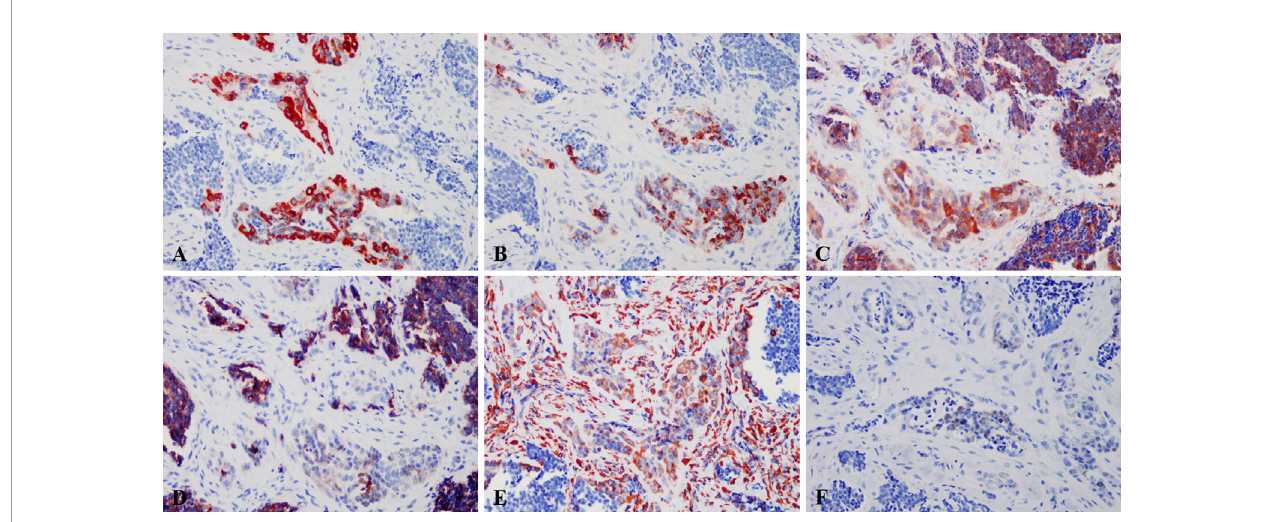
FIGURE 3 | Immunohistochemical pro fi le of MNTI. The epithelioid cells expressed Pan-CK (A) , HMB45 (B) , NSE (C) , while the smalls cells strongly expressed NSE (C) , Syn (D) . The large cells were also positive for Vim, while the small cells only showed scattered positivity (E) . Both large and small cells were negative for S-100 (F) . Immunohistochemistry,